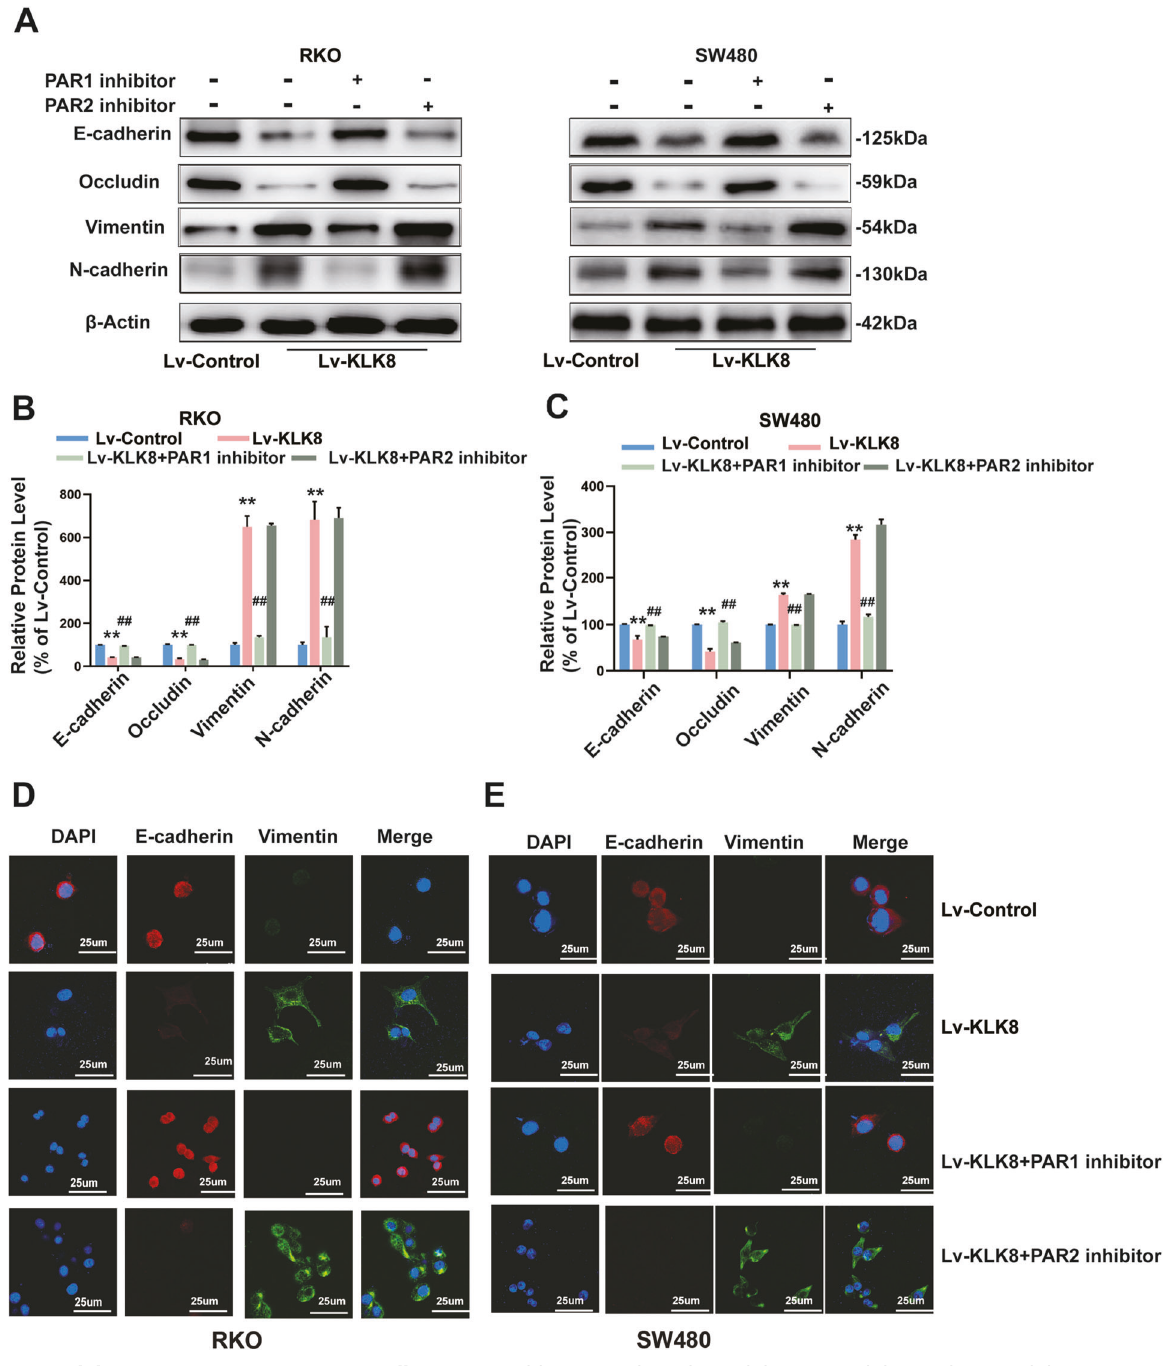
SCH79797 and PAR2 antagonist FSLLRY-NH2. All of the data are presented as the mean ± SEM from three independent experiments. ** P < 0.01 vs. Lv-control; ## P < 0.01 vs.